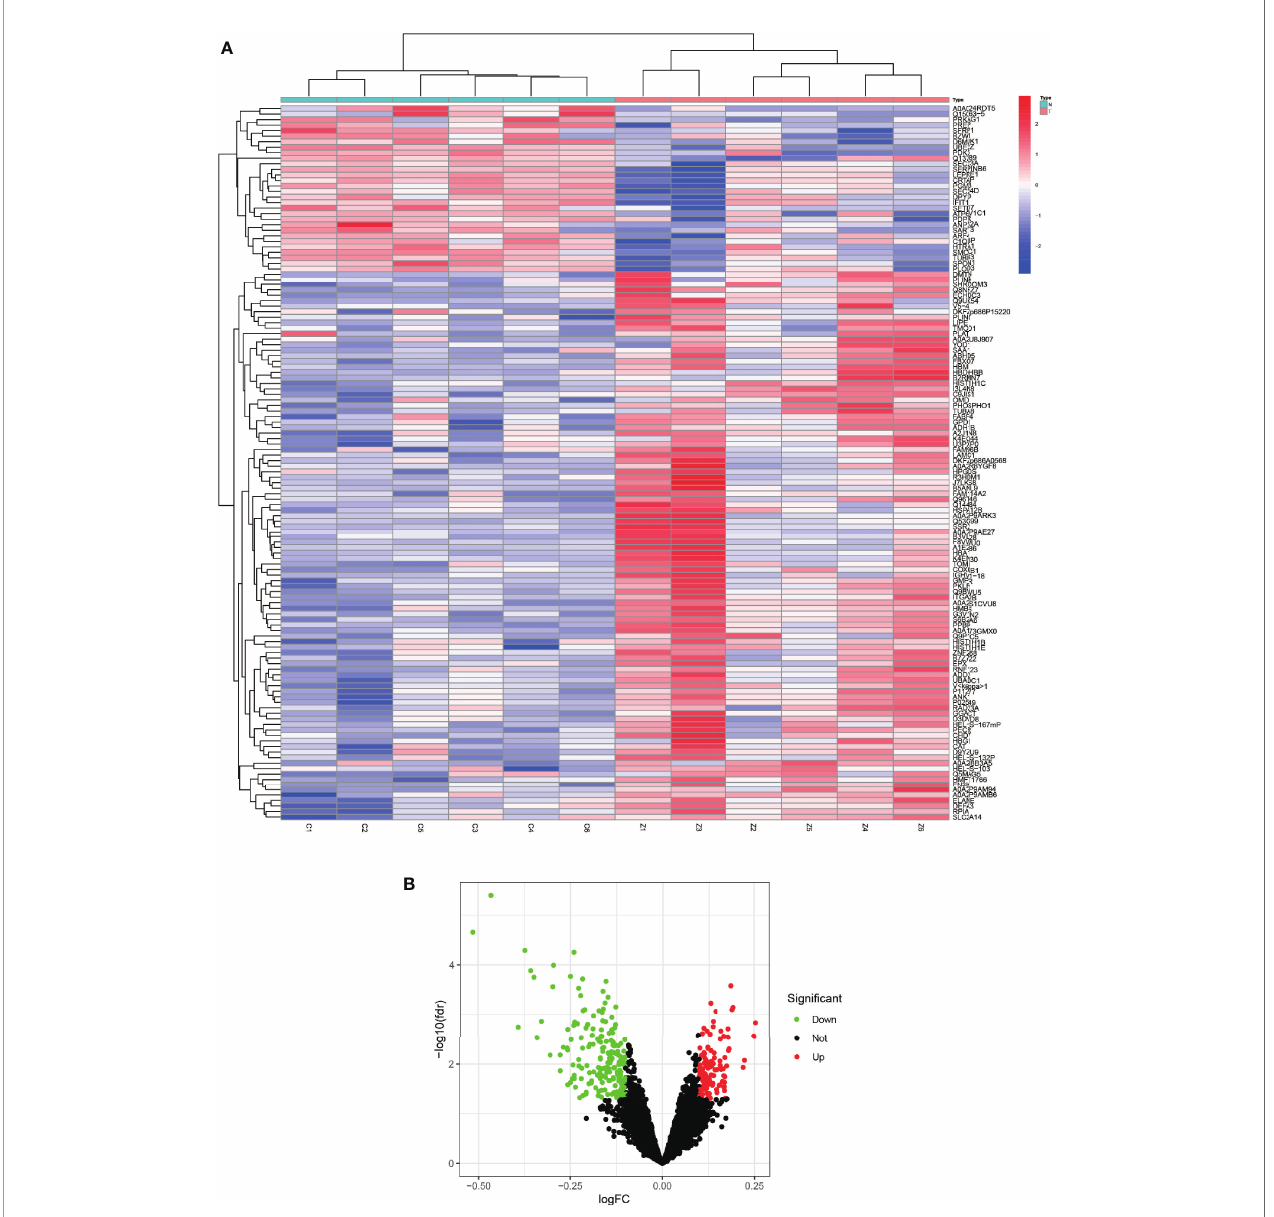
FIGURE 2 | Heat map and volcano map of differentially expressed proteins. (A) represents a heat map of the differentially expressed proteins, with the highly expressed proteins in red and the lowly expressed proteins in blue. (B) represents a volcano plot of differentially expressed proteins, with high expression proteins in red, low expression proteins in green, and proteins with insigni fi cant differences in